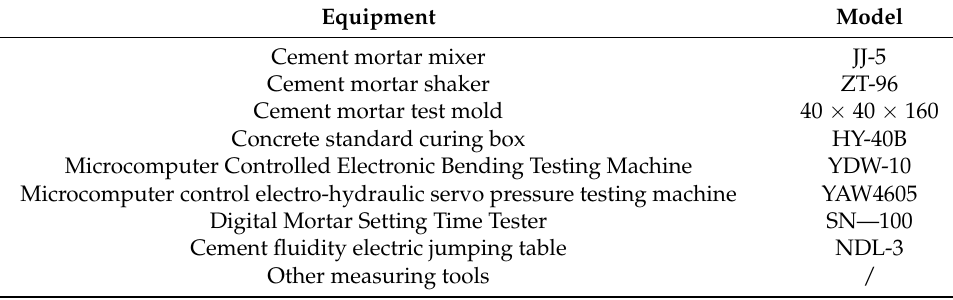
Table 6. The main equipment and instruments of the experiment.